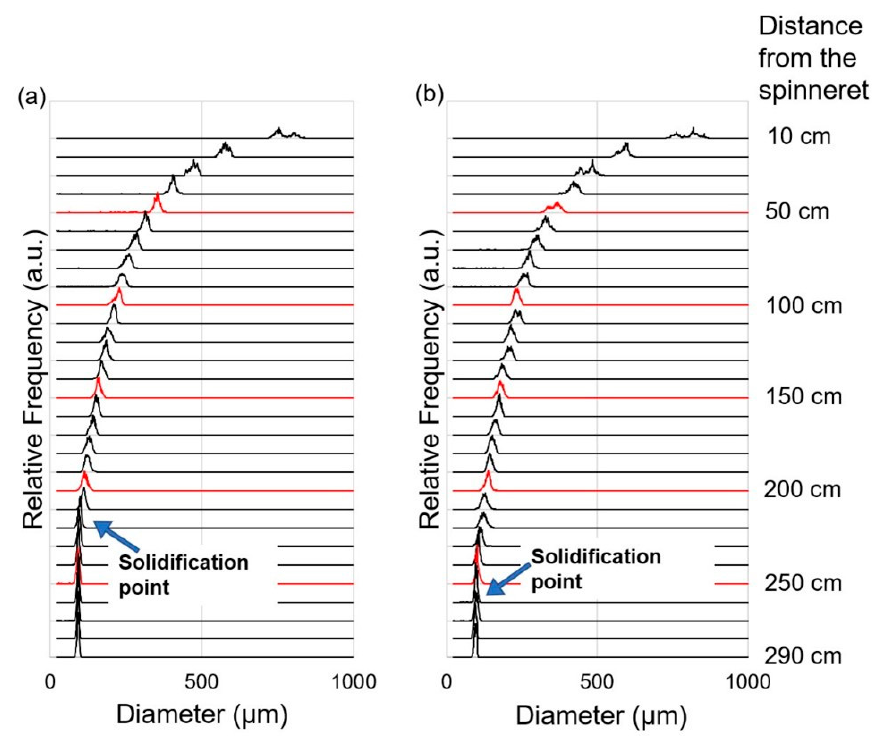
Figure 5. Diameter frequency diagrams measured for various positions of the melt spinning line for the take-up velocity of 1.0 km/min; ( a ) virgin PP, and ( b ) recycled PP.